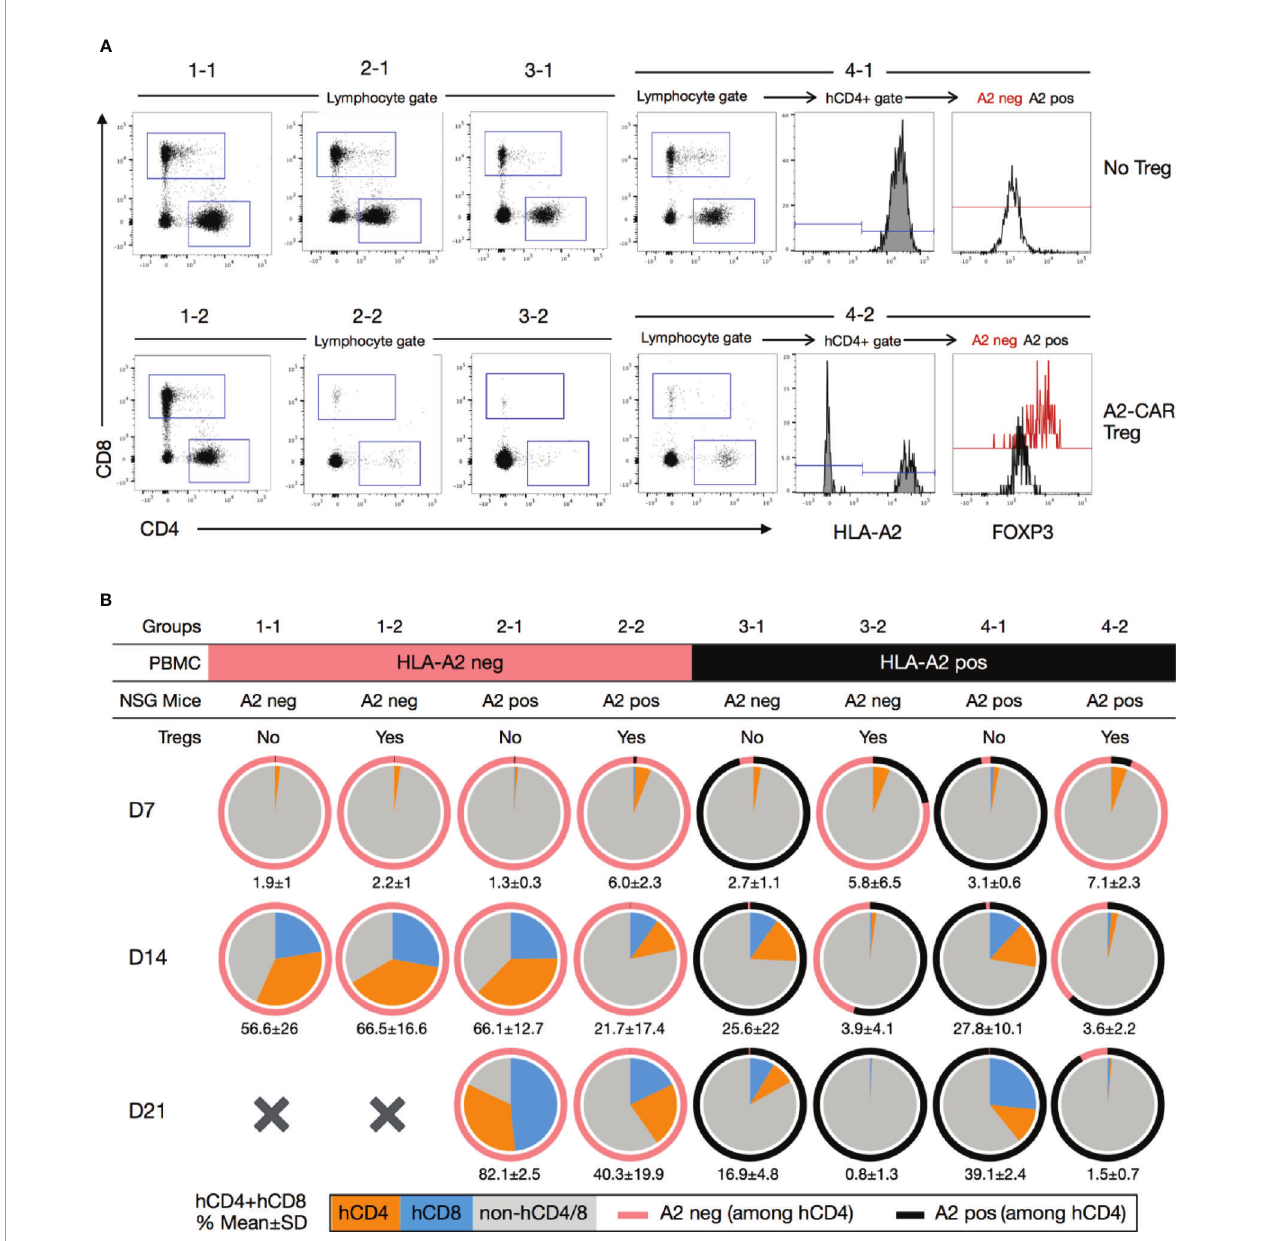
FIGURE 6 | Blood monitoring of immune reconstitution in xenogeneic graft- versus -host disease. (A) Representative staining of human CD8 + , human CD4 + and hCD4 + A2 neg FOXP3 + subpopulations after dead cell (Ghost fi xable viability dye positive) exclusion. Representative example of mice from each group (1-1, 1-2, 2-1, 2-2, 3-1, 3-2, 4-1, 4-2). (B) Pie charts showing the mean percentage of human CD4 + (orange) and CD8 + (blue) cells in the peripheral blood of mice 7 (n=4-6), 14 (n=2-5) and 21 days (n=2-4) after injection. The numbers below each pie chart represent the mean ± standard deviation of the combined percentage of human T cells (hCD4 + and hCD8 + ). A2, HLA-A2